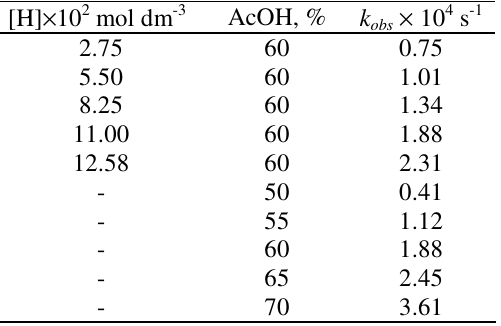
Table 2. Effect of perchloric acid [H + ] and acetic